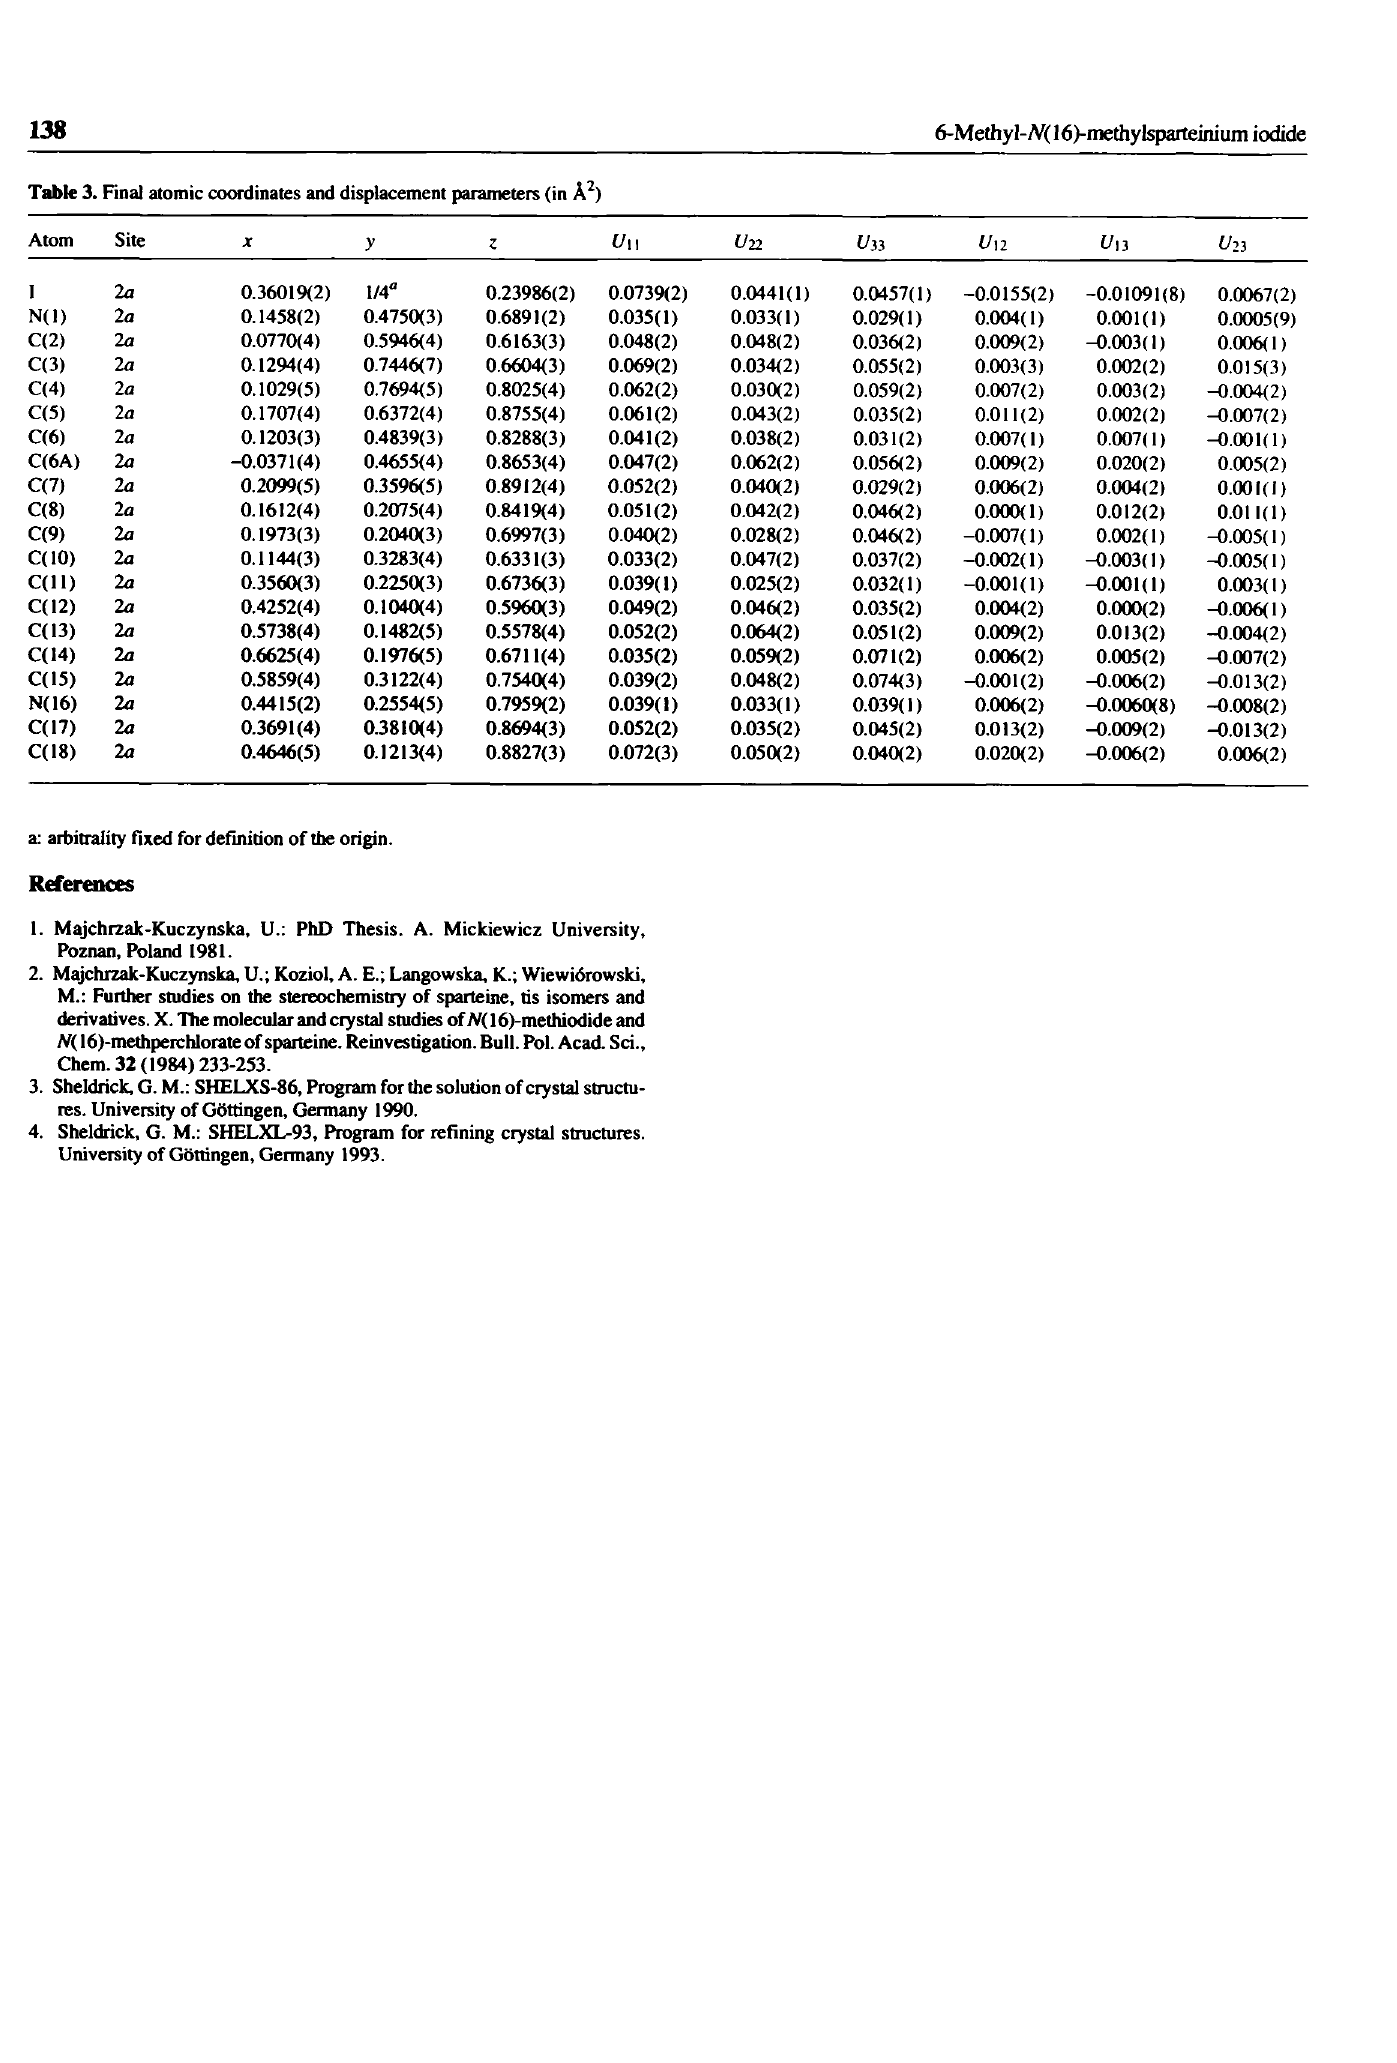
Table 3. Final atomic coordinates and displacement parameters (in Л^)